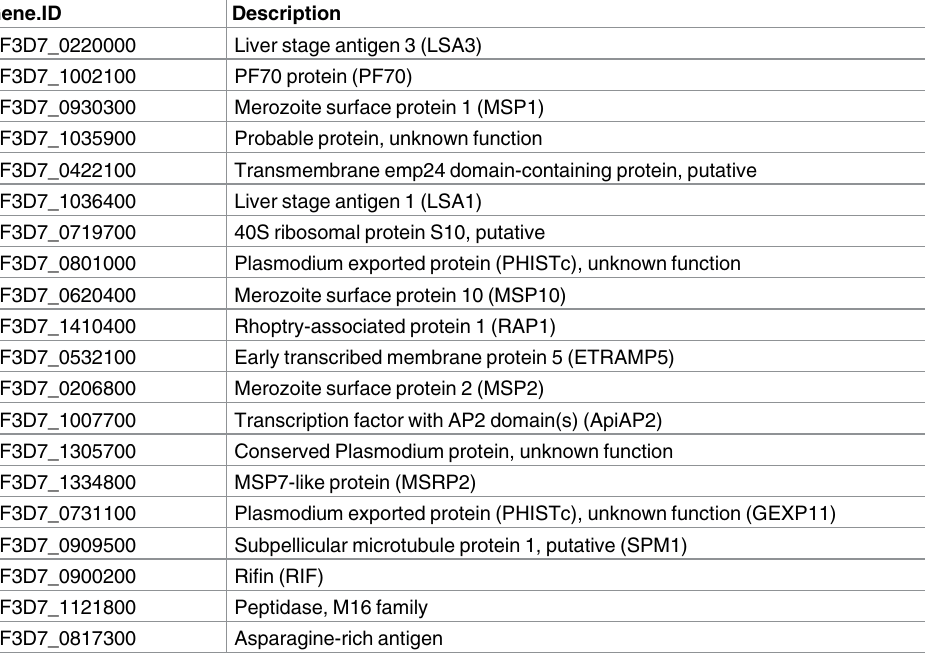
Table 2. IgG: Top 20 P . falciparum antigens by magnitude recognized by patient sera.